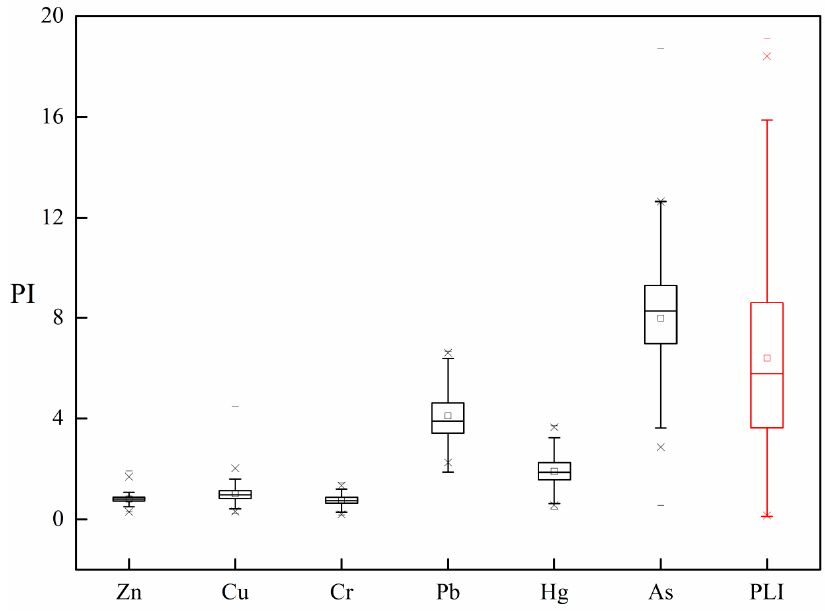
Figure 5. Box-plots of pollution index (PI) of soil heavy metals: boxes depict 25th, 50th (median), and 75th percentiles and whiskers minimum and maximum values. Mean values (O); outliers (*).